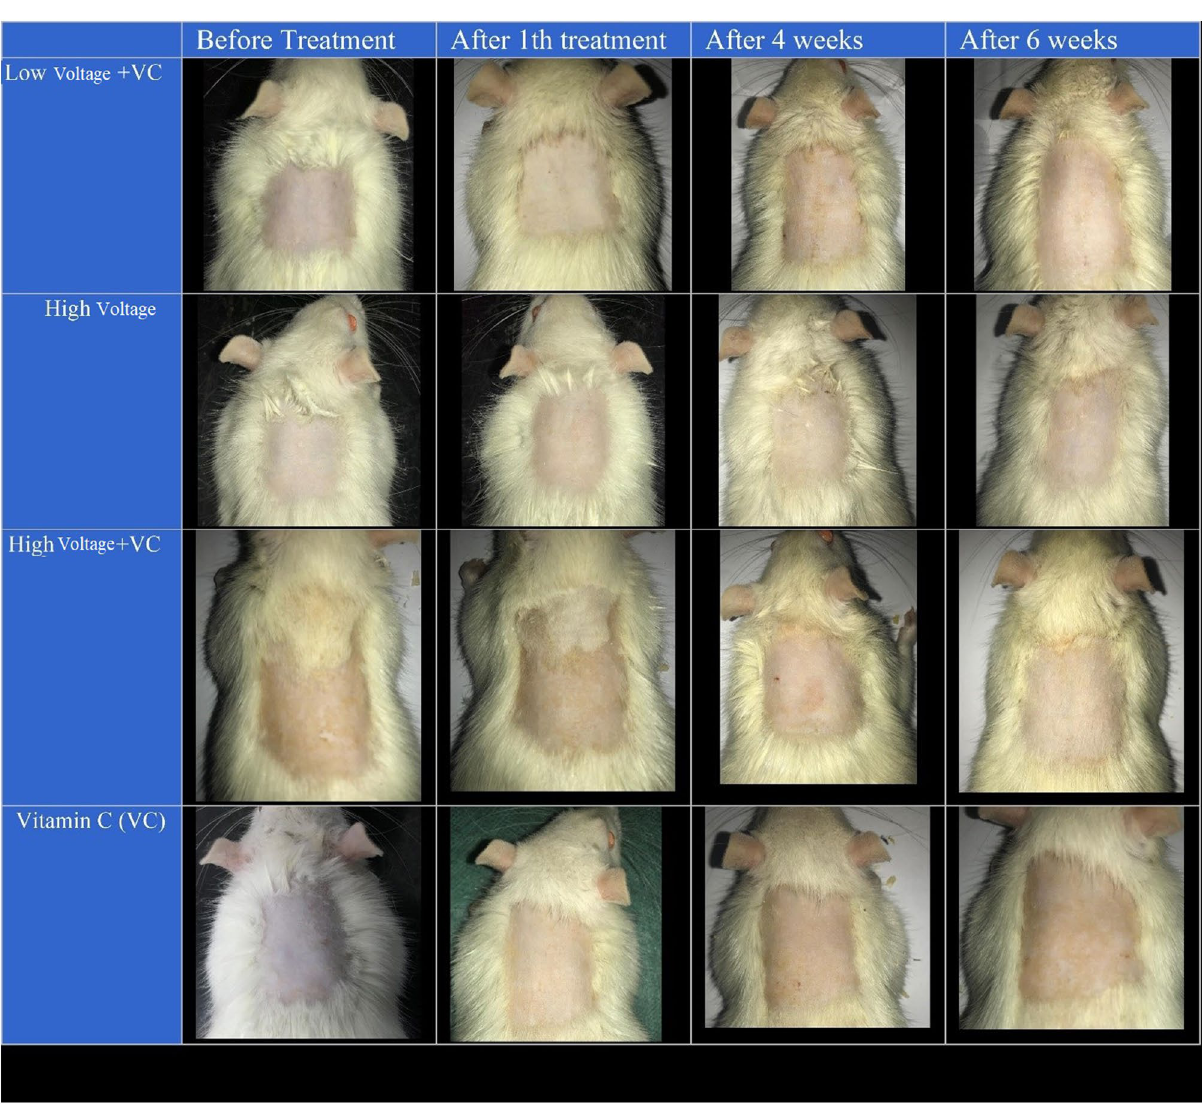
Figure 4. Visual observation of plasma performance in the rats during 6